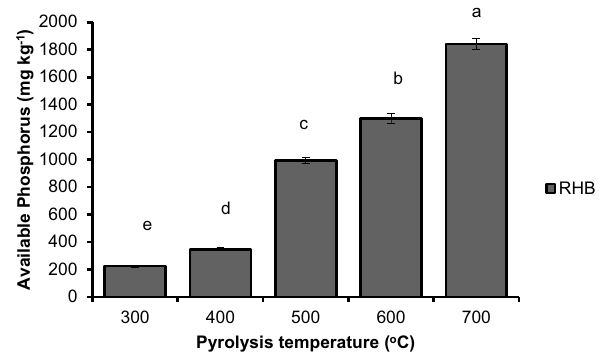
Fig. 1 Available phosphorus (Olsen P) concentration of rice husk biochar (RHB)